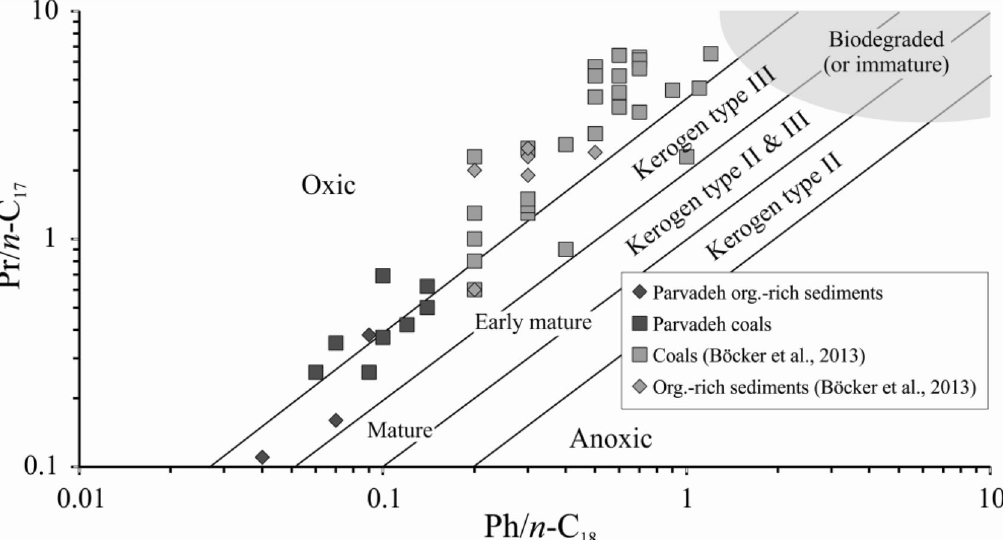
Fig. 8 Pristane/ n -C17 versus Phytane n -C18 plot after Shanmugam (1985) showing the Parvadeh samples in comparison to less mature samples from the Ruhr Basin (Germany)